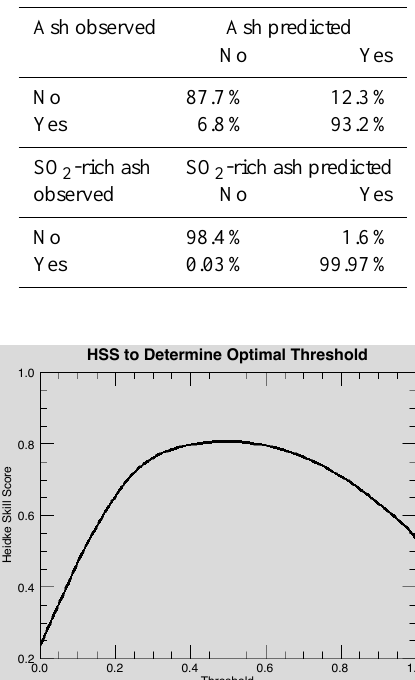
Table 2. (Top) Ash-detection neural network output was compared to the test data set output to measure success; (bottom) SO 2 -rich- ash-detection neural network output was compared to the test data set to measure success.